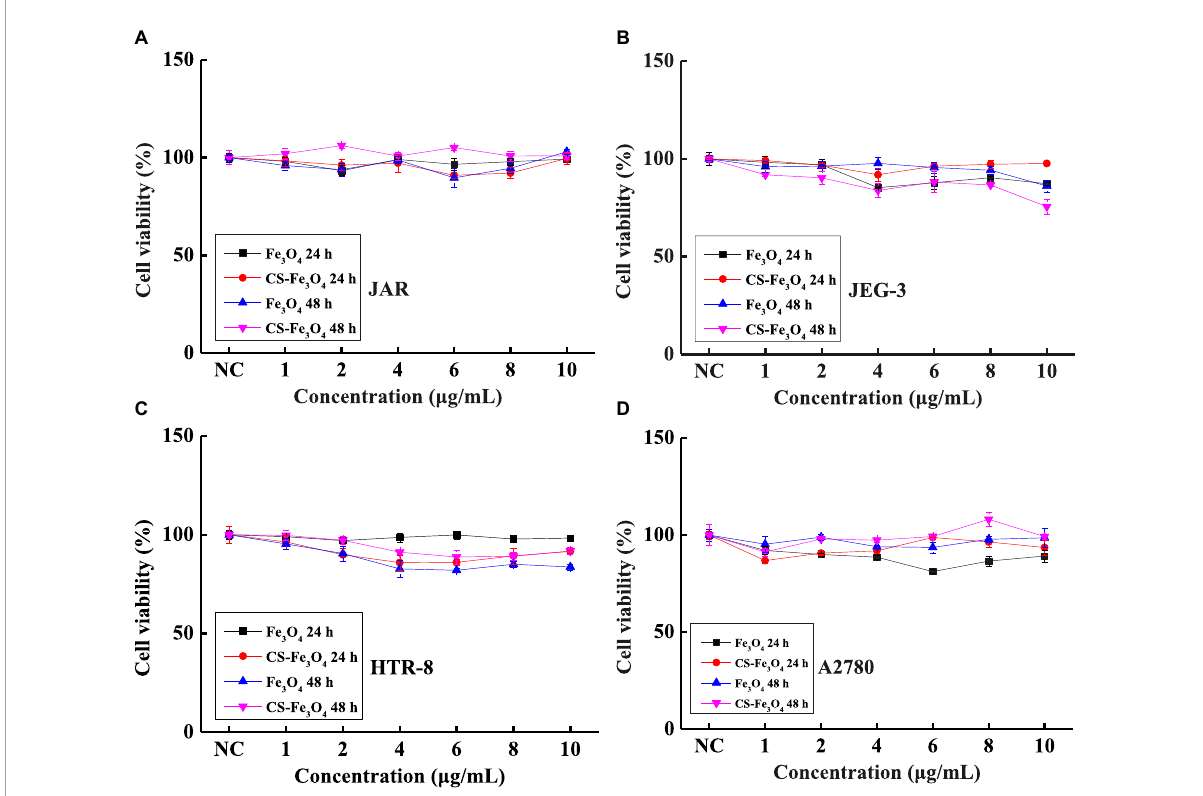
FIGURE4 Cell viability of (A) JAR cells, (B) JEG-3 cells, (C) HTR-8 cells, and (D) A2780 cells with Fe 3 O 4 and CS-Fe 3 O 4 nanoparticles under different concentrations and treatment periods.